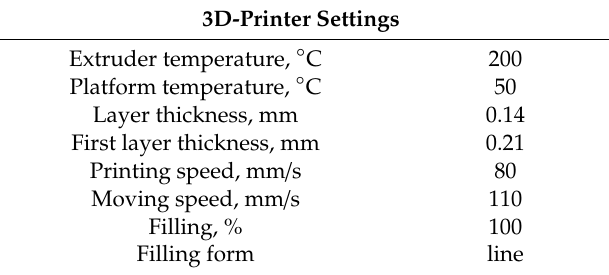
Table 1. 3D-printing